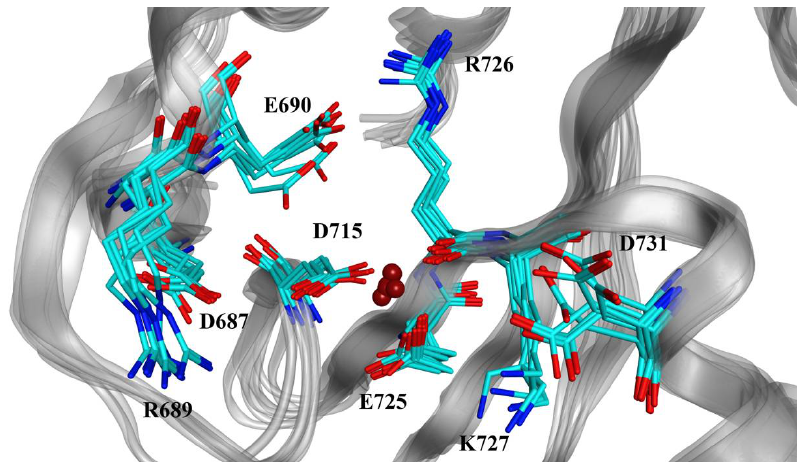
Figure 3. Superposition of the seven conformations of the human XPF active site obtained by clustering the molecular dynamics (MD) trajectory and including the lowest potential energy conformation. The set of conformations was then used as a target for the molecular docking simulations. Carbon, nitrogen and oxygen atoms are represented in cyan, blue and light red, respectively. Dark red spheres indicate the positions of the Mg 2+ ion present in the active site and coordinated by D715, E725, and R726.